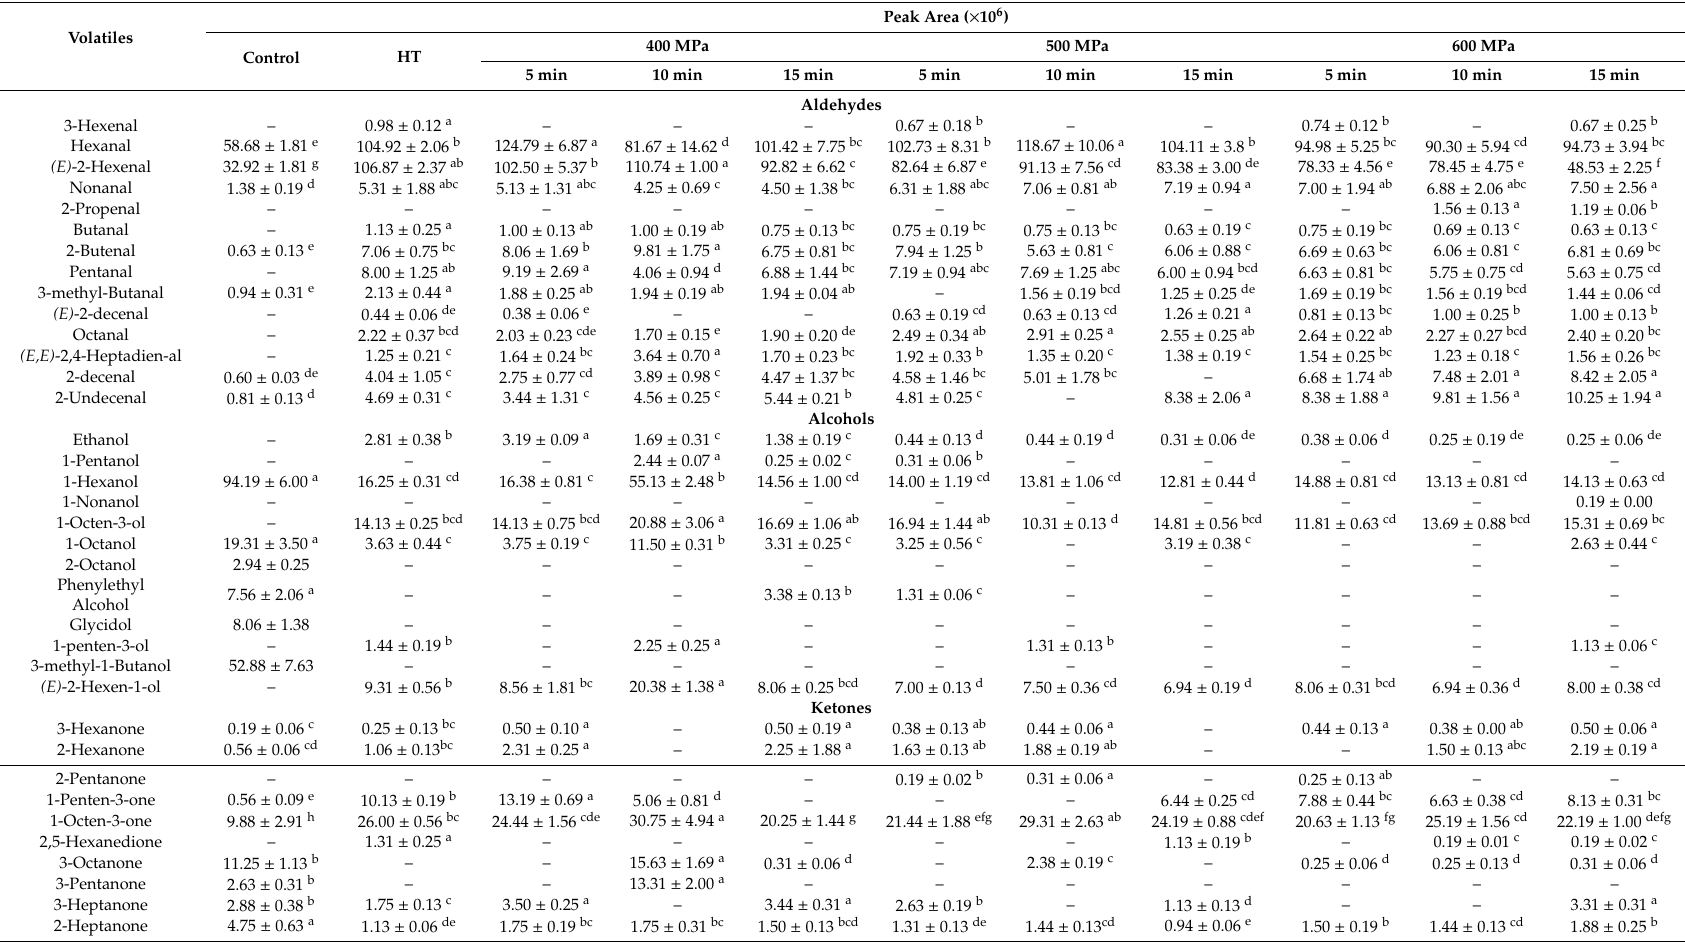
Table 3. Changes of volatiles in kiwifruit pulp beverage treated with HHP on day